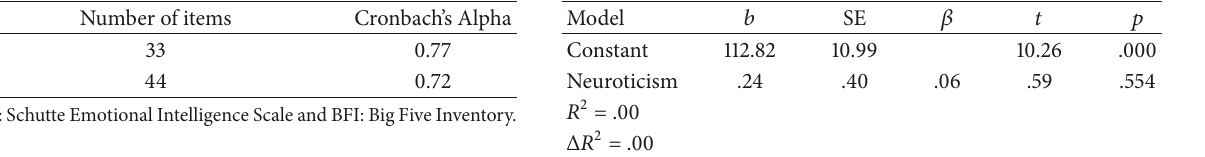
Table 3: Linear regression analysis indicating extraversion as the predictor of EI ( 𝑁 = 100 ).